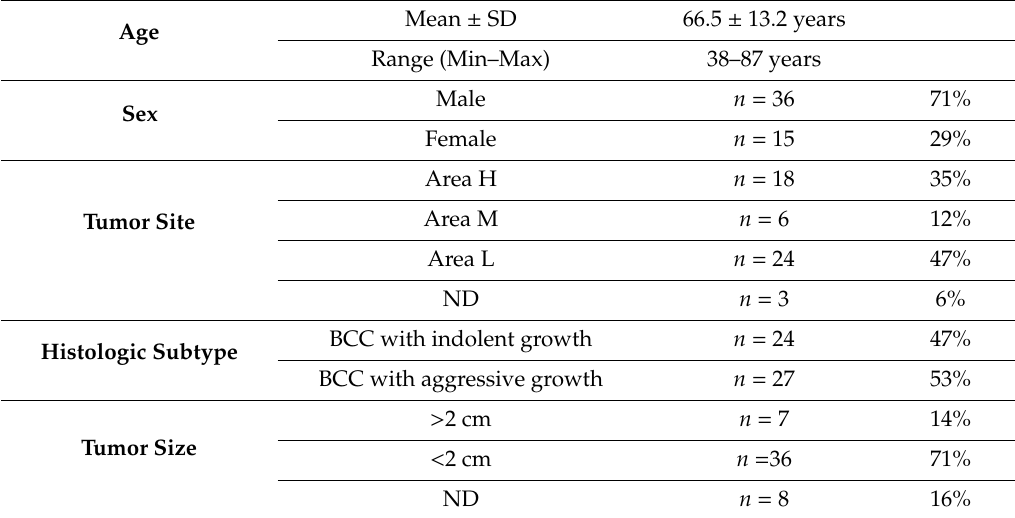
Table 2. Clinicopathological characteristics of the study